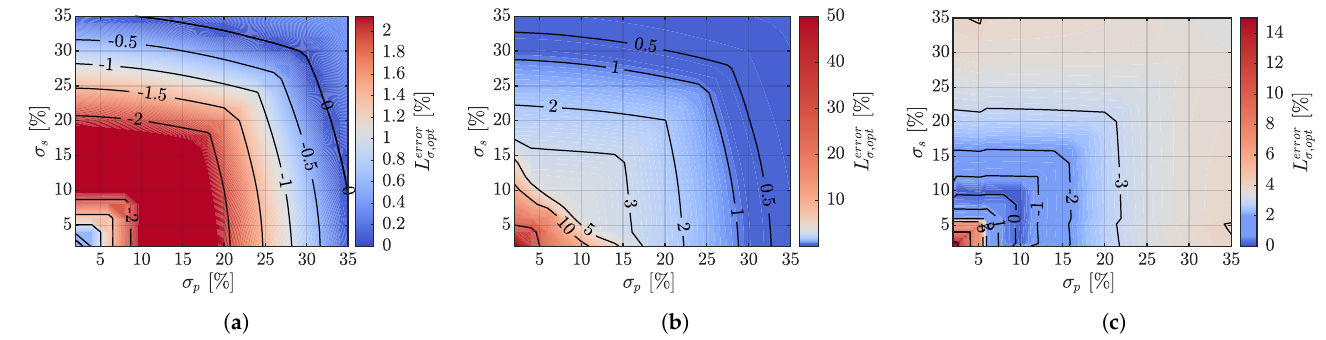
Figure 10. The percentage of error in the estimation L σ ,opt , using analytical formulas (23)–(26), for the dc–dc converter with the given specifications in Table 1. ( a ) For the 3 φ YY-connected MFT . ( b ) For the 3 φ Y ∆ -connected MFT. ( c ) For the 1 φ MFT.